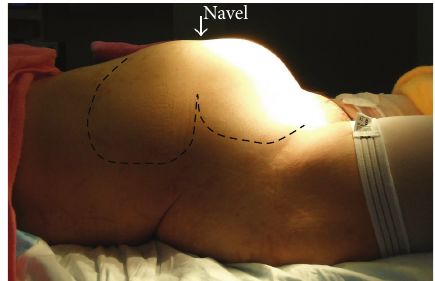
Figure 1: Abdominal tumor extending beyond the navel.